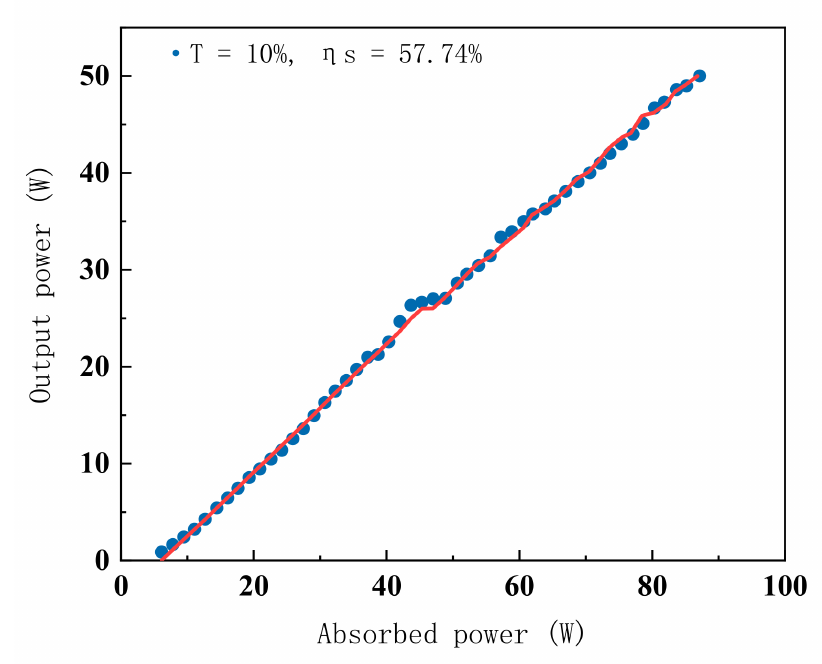
Figure 2. Output power versus absorbed power of Tm:YAP laser.